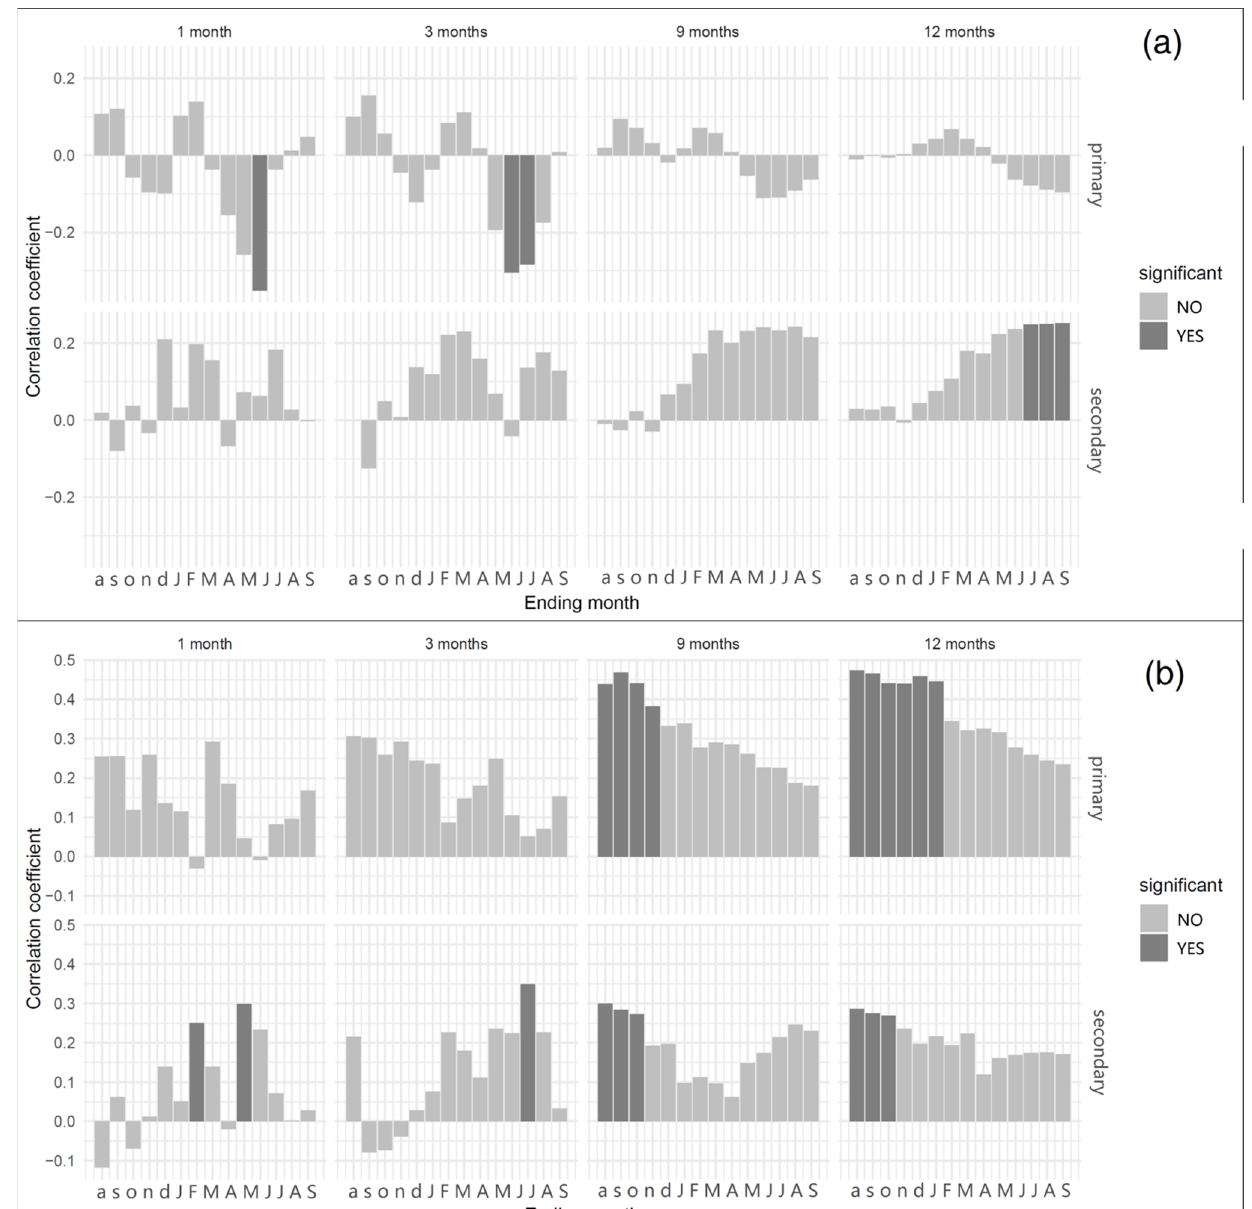
Figure 4. Moving window correlations between the ( a ) TRW chronology of Tajikistan and temper- ature; ( b ) TRW chronology of Tajikistan and precipitation; ( c ) ∆ 13 C chronology of Tajikistan and temperature; ( d ) ∆ 13 C chronology of Tajikistan and precipitation of the previous March to the cur- rent November. The moving correlation was conducted in windows of 18 year, offset by 2 a. Blue shading indicates a positive correlation; red shading indicates a negative correlation. The asterisk (*) indicates a statistically significant correlation.